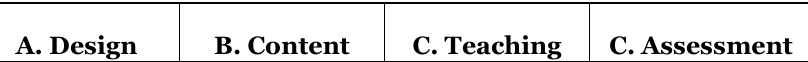
The Open Educators Factory